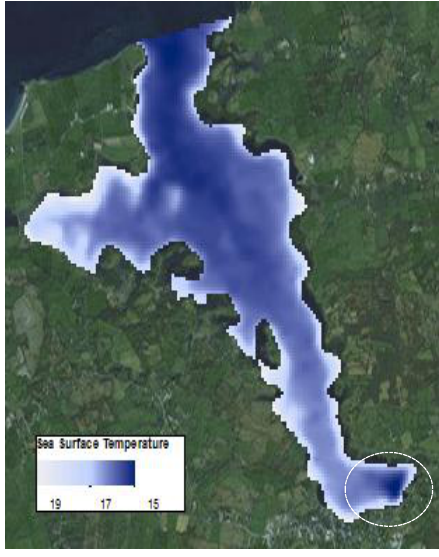
Figure 6. July 2013 sea surface temperature map of Kinvara Bay generated from Landsat 8 satellite imagery [14].